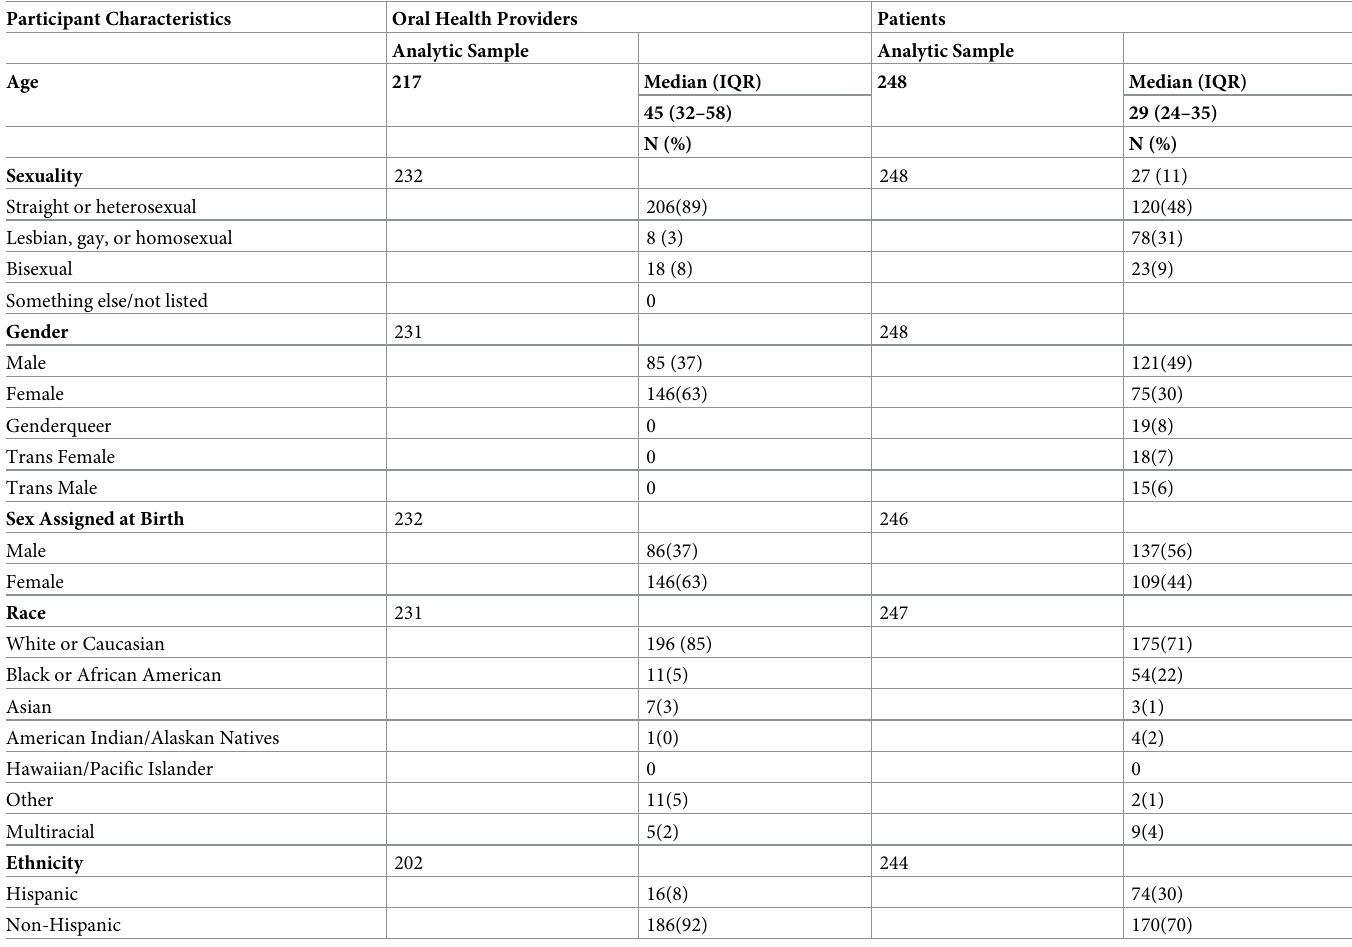
Table 1. Participant